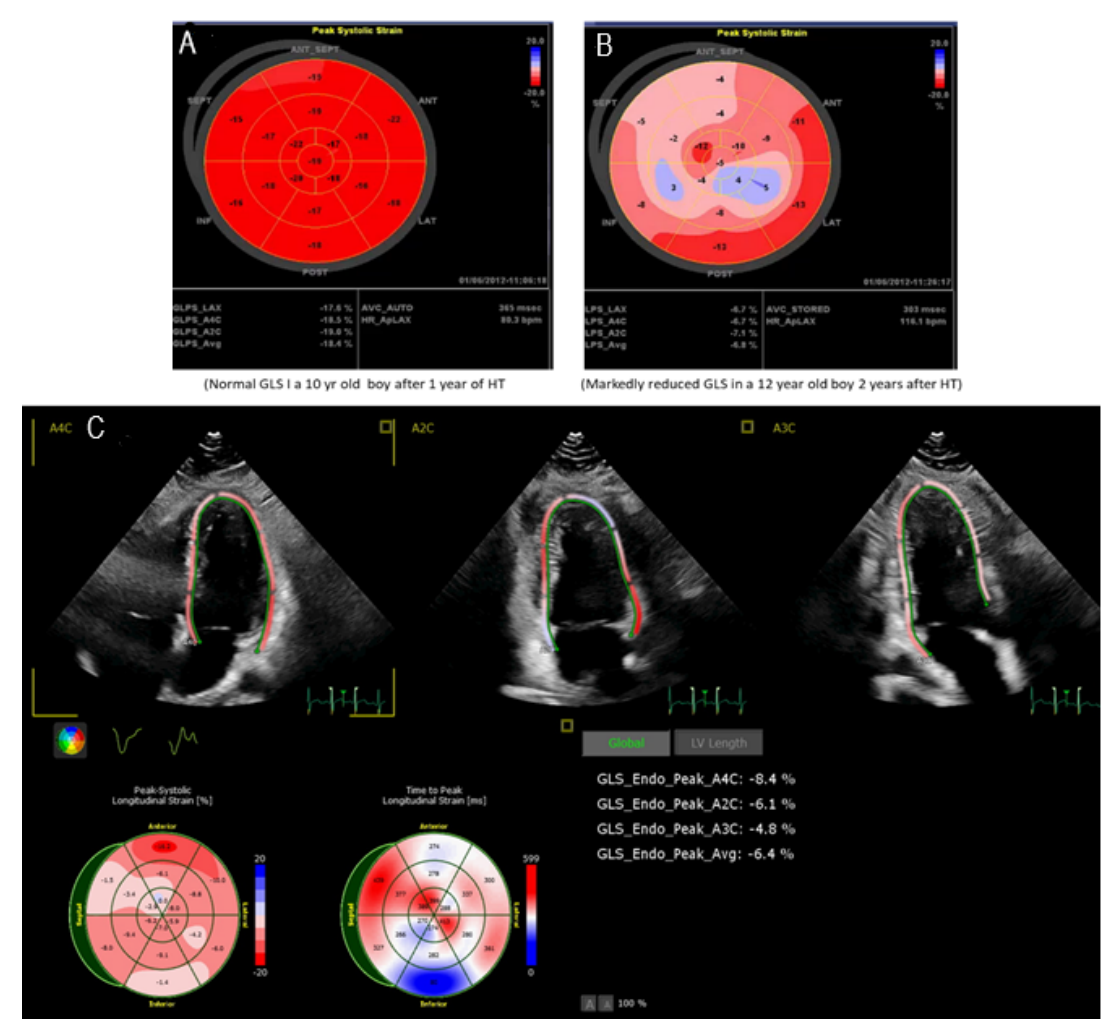
Figure 3. ( A ) Normal global longitudinal strain, ( B ) Markedly decreased global longitudinal strain; and ( C ): Average of global longitudinal strain, markedly decreased in a 15-year-old boy after 2 years of HT.